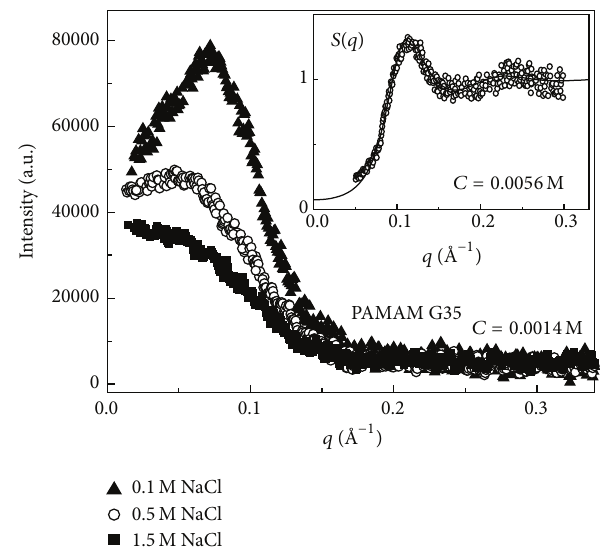
Figure 4: SAXS spectra of amine terminated (G4) and sodium carboxylate terminated (G3.5) PAMAM dendrimers in methanol solution at the concentration of 𝐶 = 20 wt.%. The presence of a peak in the SAXS spectra (more pronounced for the G3.5 system) gives indication that a long range structural order between dendrimers of electrostatic origin is present in solution.